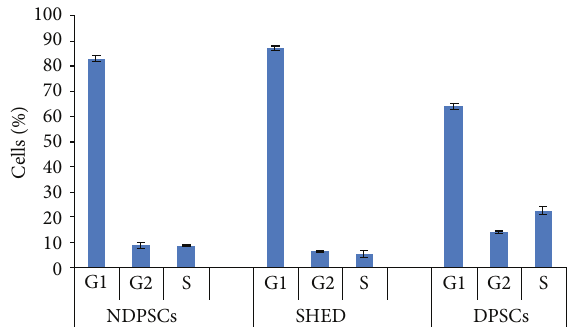
Figure 2: Cell cycle analysis of NDPSCs, SHED, and DPSCs. Each sample (10,000 cells) was counted in triplicate by a flow cytometer. The values are expressed as percentage mean ± standard deviation.